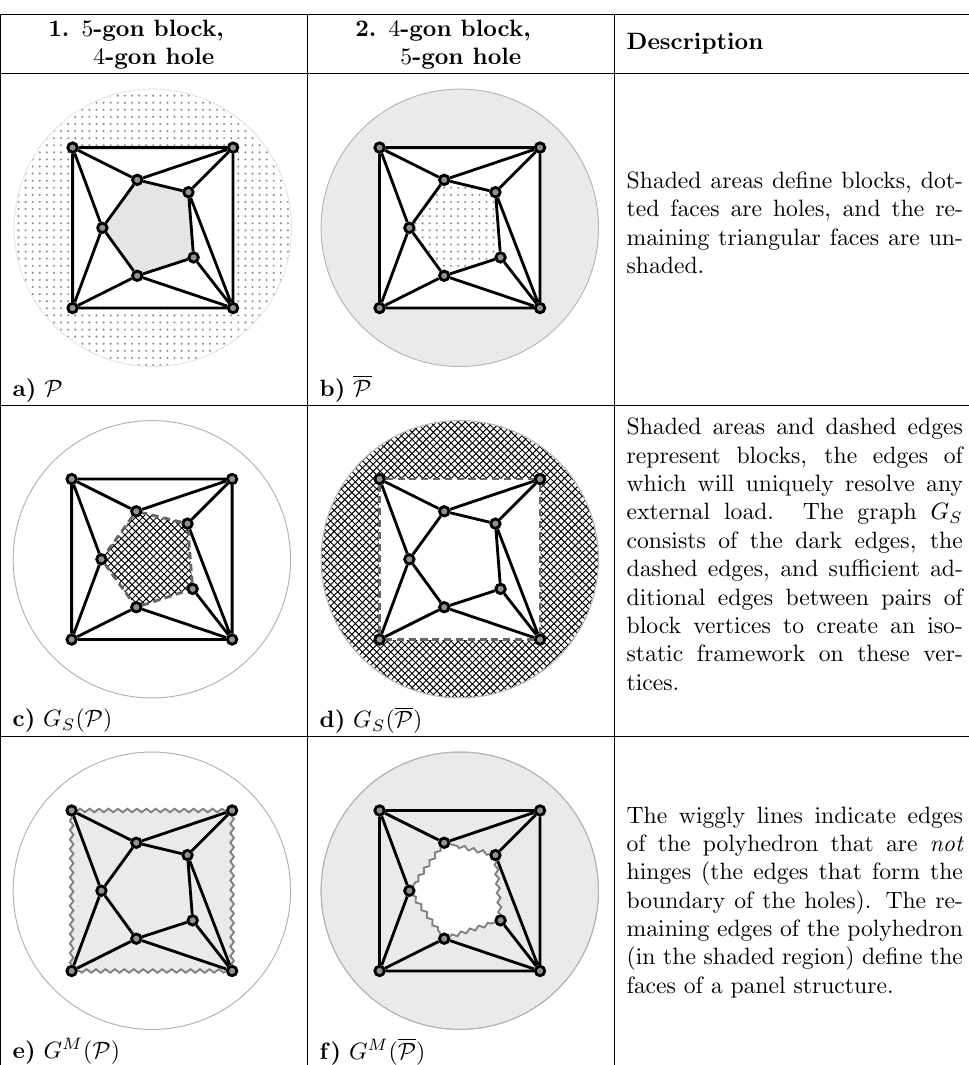
Figure 62. Examples of block and hole polyhedra, and their associated graphs for tracking stresses G S ( P ) and tracking hinge motions G M ( P ) . Figure by Elissa Ross, reused with permission